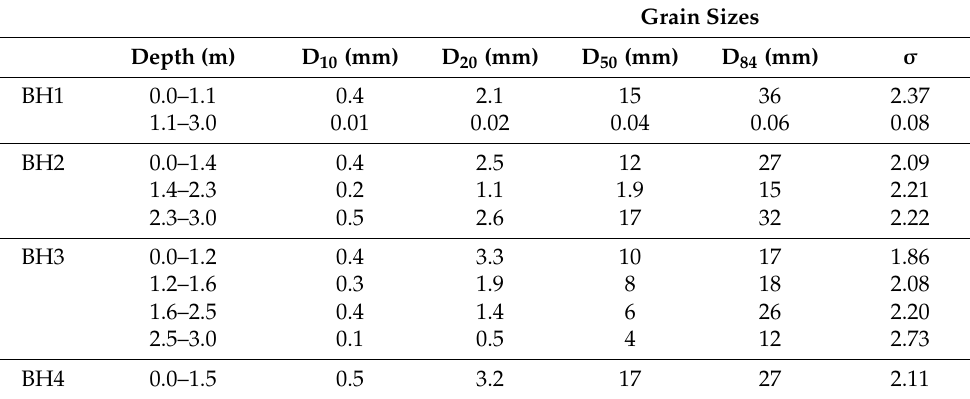
Table 2. Representative grain sizes and sorting estimated for clastic sediments in borehole logs. Rambla de la Azoh í